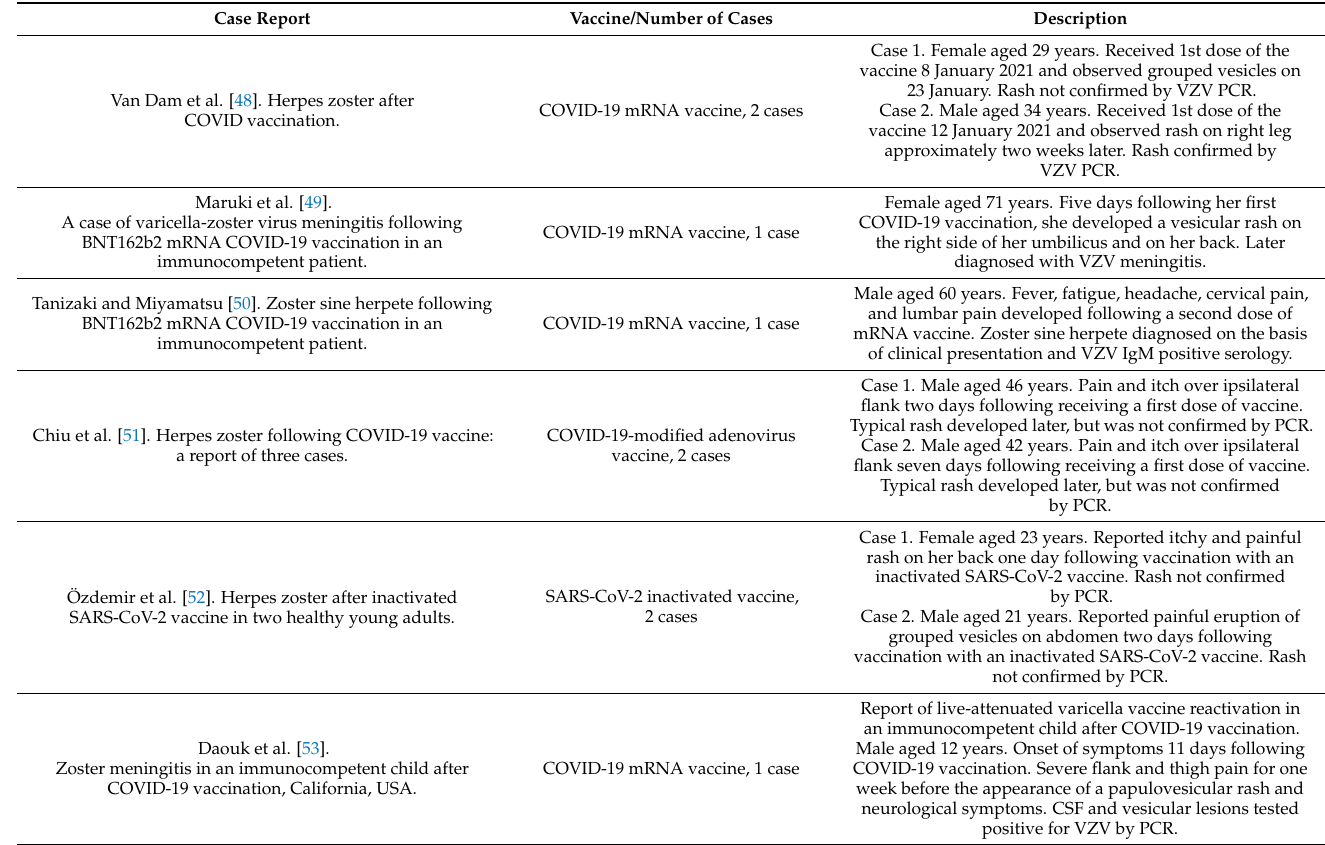
Table 3. Selected case reports of herpes zoster following COVID-19